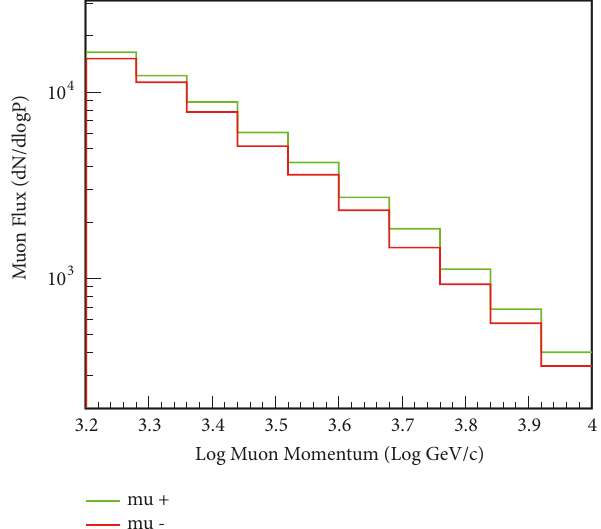
Figure 8: Differential Muon flux generated using CORSIKA at the top of the hill as a function of muon momentum at log scale.